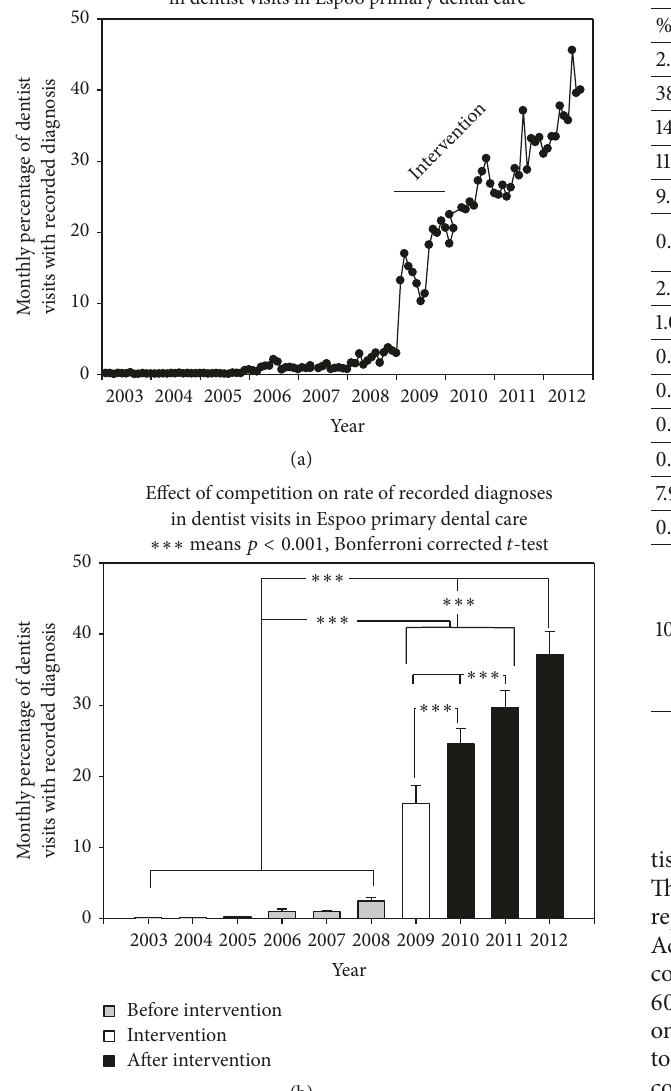
Table 1: Diagnoses made by primary care